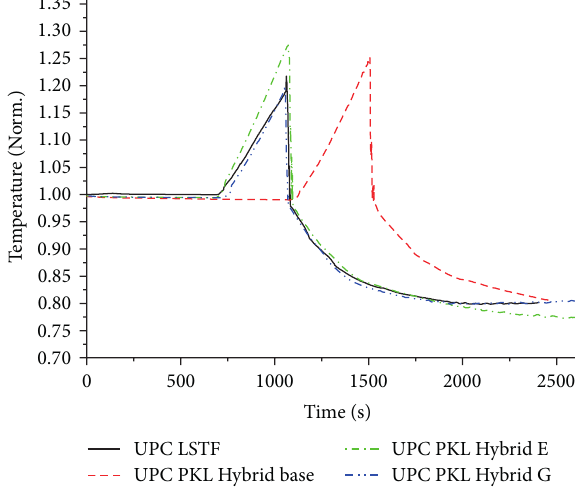
Figure 38: Core exit